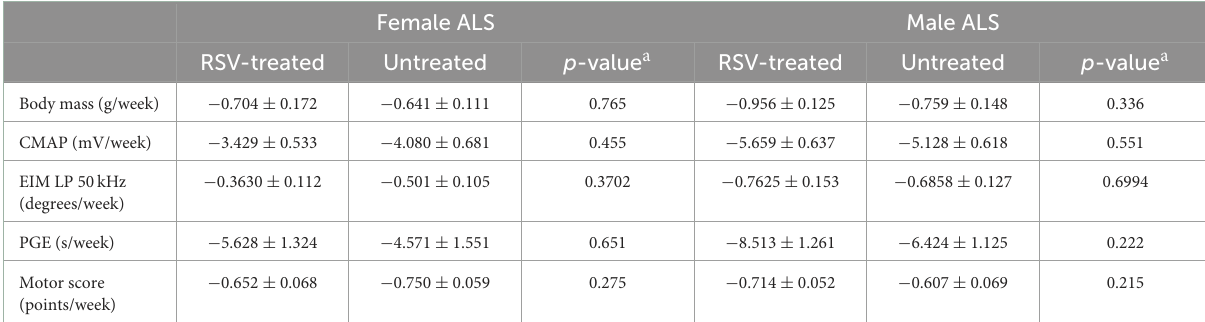
TABLE 2 Rates of change for body mass, CMAP amplitude, LP 50kHz, PGE, and motor score in RSV-treated vs. untreated ALS animals.